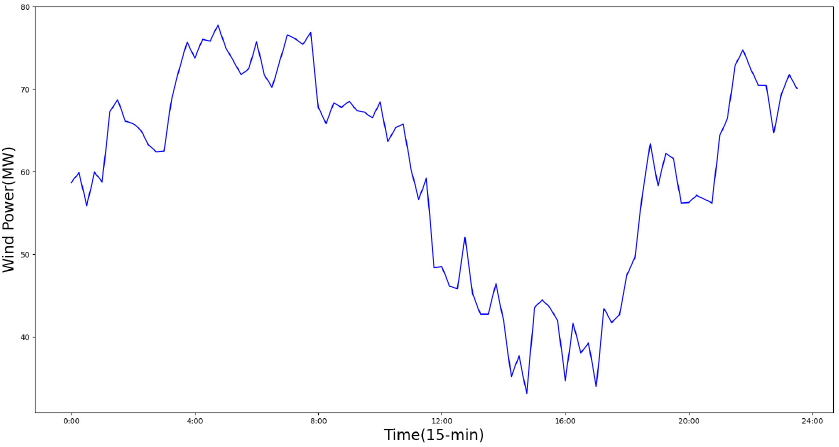
Figure 6. Wind power trend in